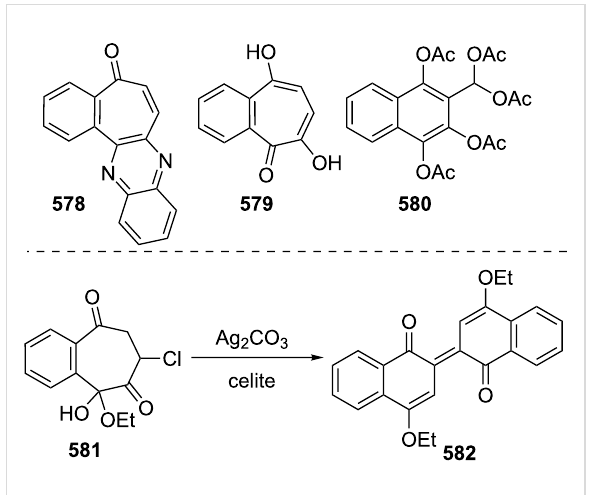
Figure 37: Two possible structures 583 and 584 for dibenzotropo- quinone, and precursor compound 585 for 583 .